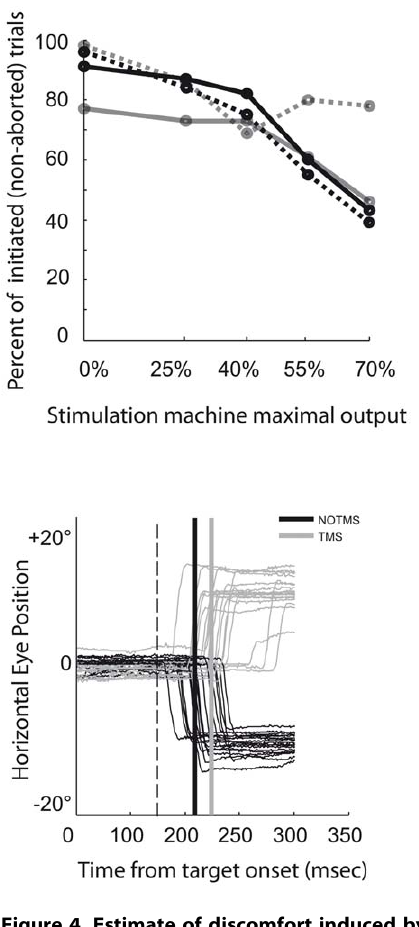
Figure 4. Estimate of discomfort induced by TMS. Estimation of discomfort based on the interaction between percent of initiated trials (used as an indirect correlate of the level of discomfort; the higher the discomfort the lower the number of initiated trials) and TMS intensity (% of machine maximal output). ( Upper panel) Note that below 50% intensity, low discomfort is inferred from the high percent of initiated trials (grey and black lines) respectively for monkey ‘C’ and ‘Y’, for the TMS condition (dotted lines) as compared to the sham TMS condition (solid lines). ( Bottom panel ) Representative traces of eye movement with/without TMS (respectively grey, black lines) at 50% intensity for one of the monkeys. At least for the two SOAs used in the study (100 and 150 ms) eye movement metrics were not affected by TMS. Furthermore, no saccades were elicited by the stimulation.